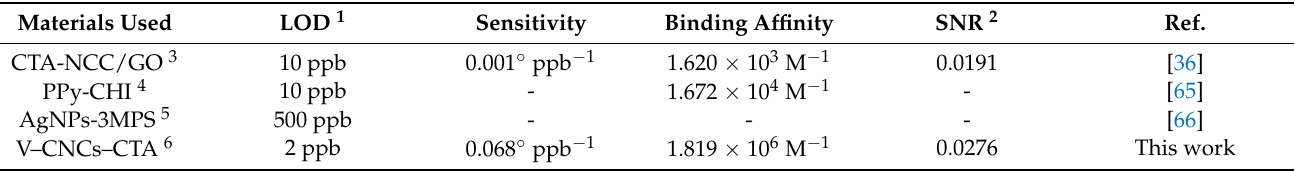
Table 3. Surface plasmon resonance for Ni(II) ion detection presented in the previous report.